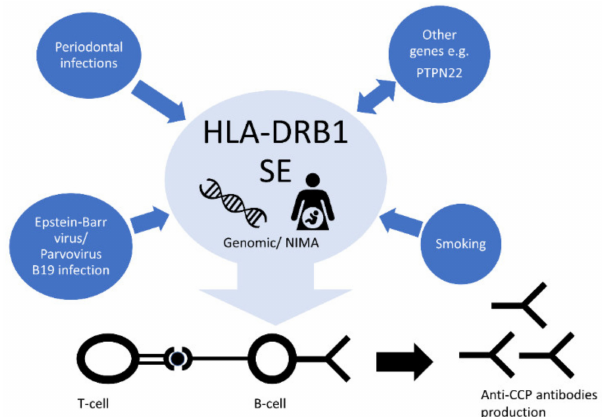
Figure 5. HLA-DRB1 interactions leading to the development of RA. By contributing to autoimmunity, the HLA-DRB1 SE alleles may interact with environmental factors such as smoking, Epstein–Barr virus (EBV), Porphyromonas gingivalis infection, as well as other susceptibility